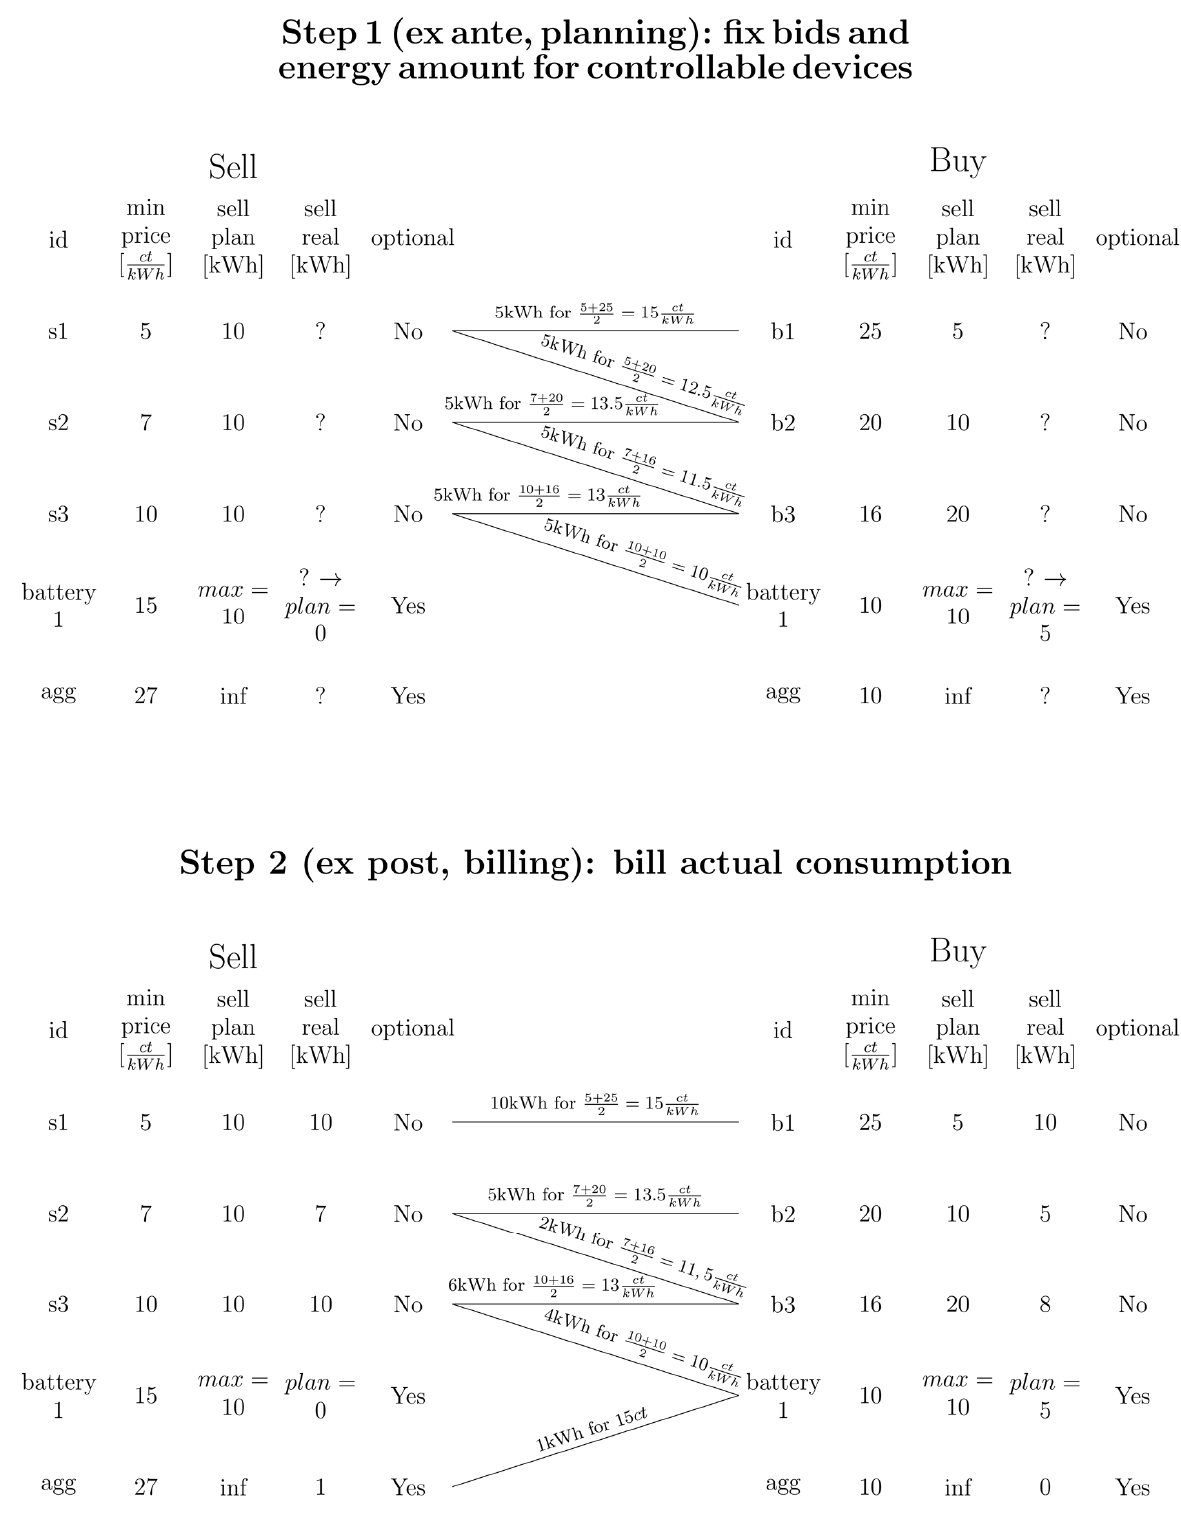
Figure 4. Clearing mechanism for limit orders with controllable systems and possibility for divergent consumption and